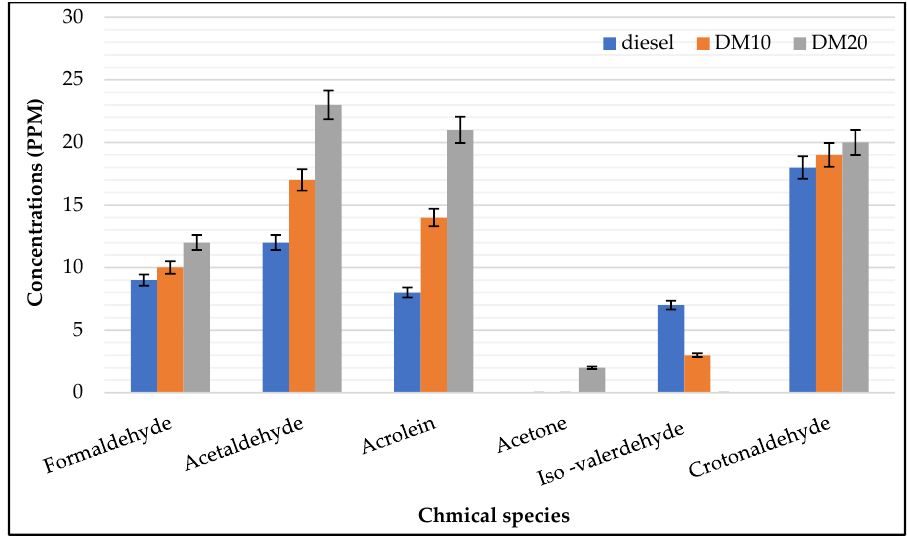
Figure 8. Emissions concentration with carbonyl compounds speciation (8 bar NMEP).